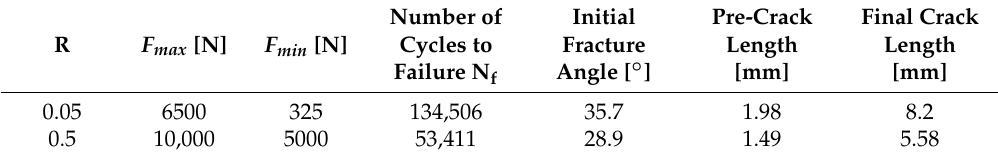
Figure 17. Mixed mode fatigue crack path in the CTS specimen ( a ) for R = 0.5; ( b ) for R = 0.05.